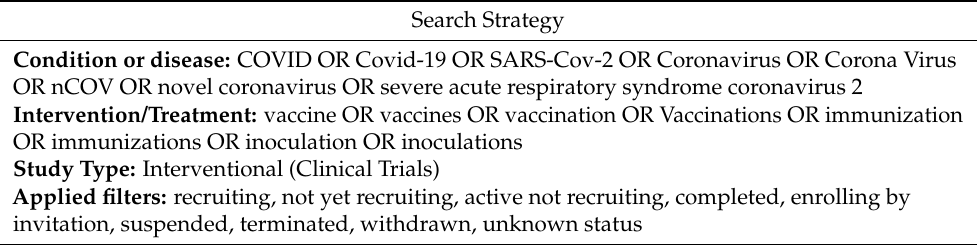
Table 1. Search strategy, inclusion and exclusion criteria for rapid review. Search